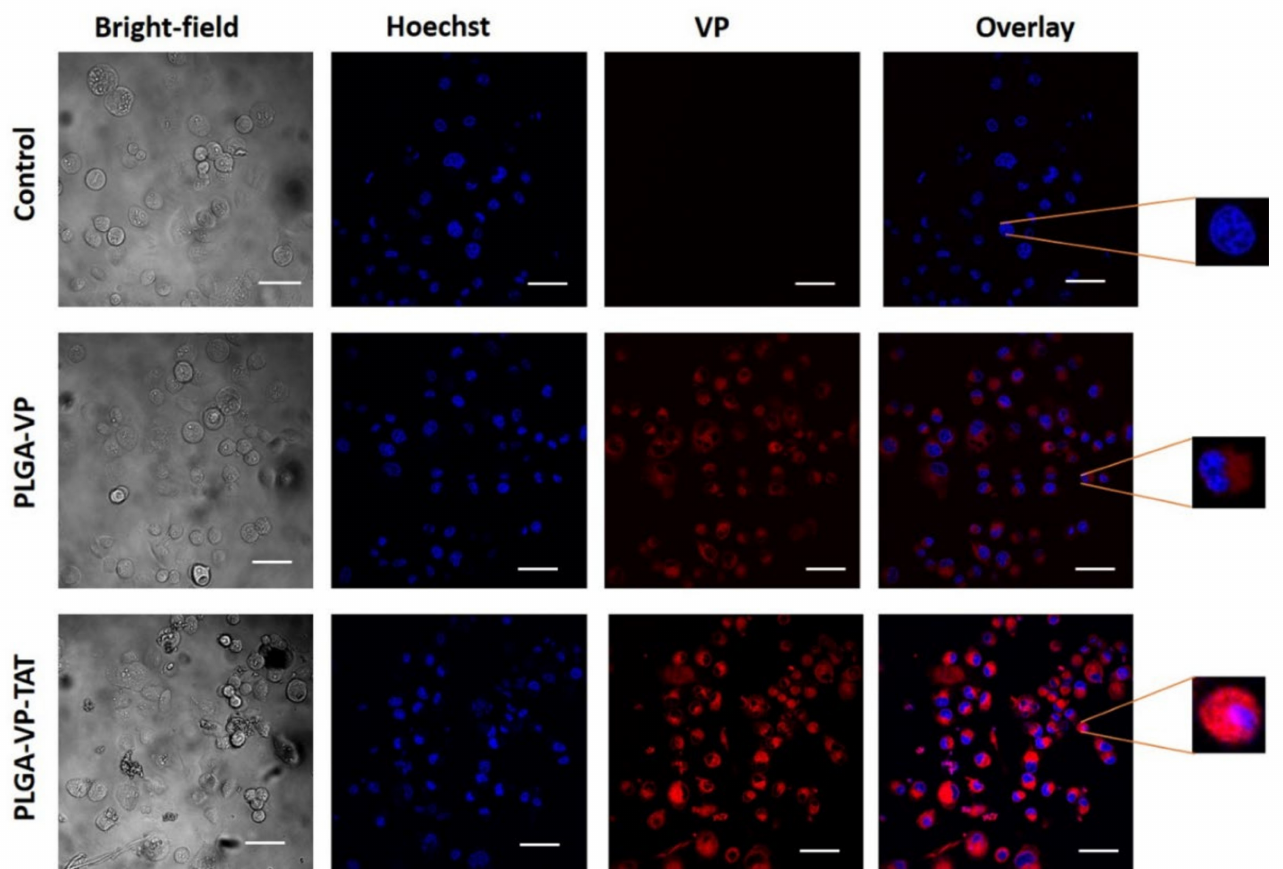
Figure 2. Representative confocal images showing the uptake of PLGA–VP and PLGA–VP–TAT nanoparticles in PANC-1 cells after 4 h incubation: blue-Hoechst nuclear stain, red-VP fluorescence. Magnified single-cell images are shown on the right. Scale bar: 50 µ